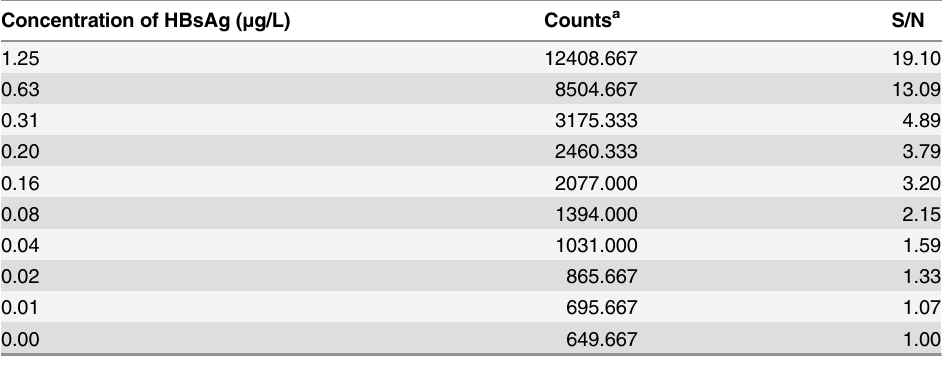
Table 3. Functional sensitivity of BC-EDTA/Eu 3+